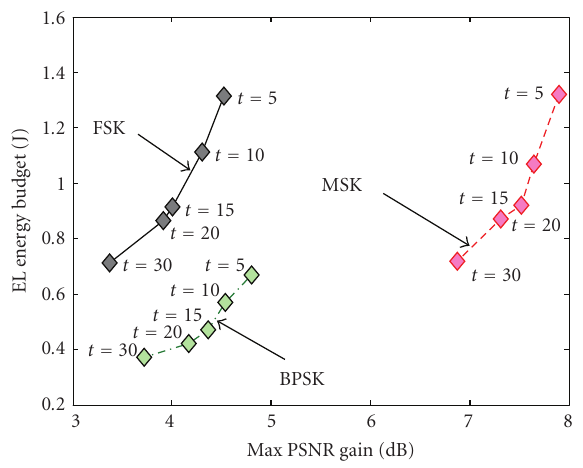
Figure 15: Relationship between PSNR gain of cross-layer UEP strategy against EEP and available energy